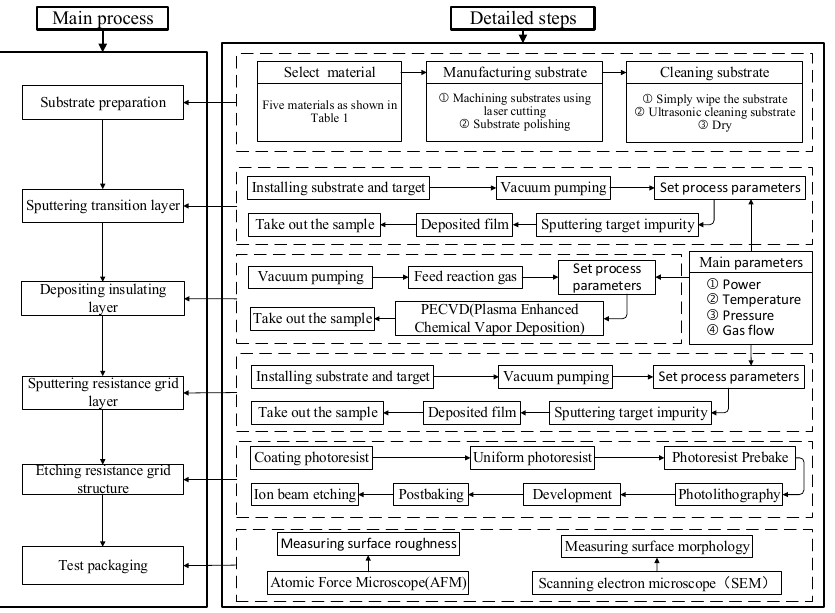
Figure 1. Process flow diagram.